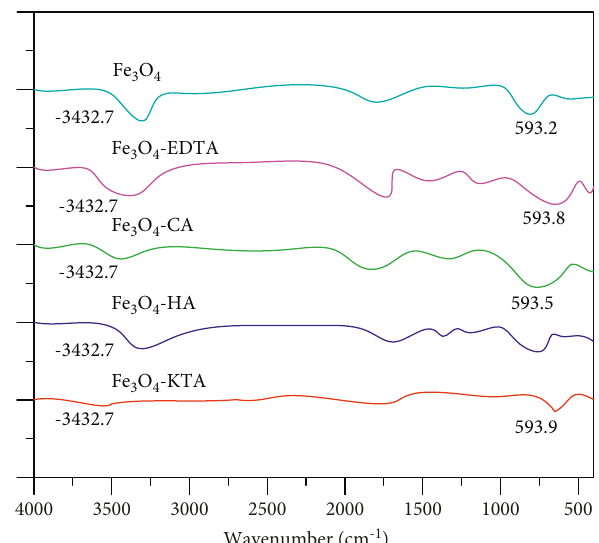
Figure 5: Infrared absorption spectra of Fe molecule acetic acid